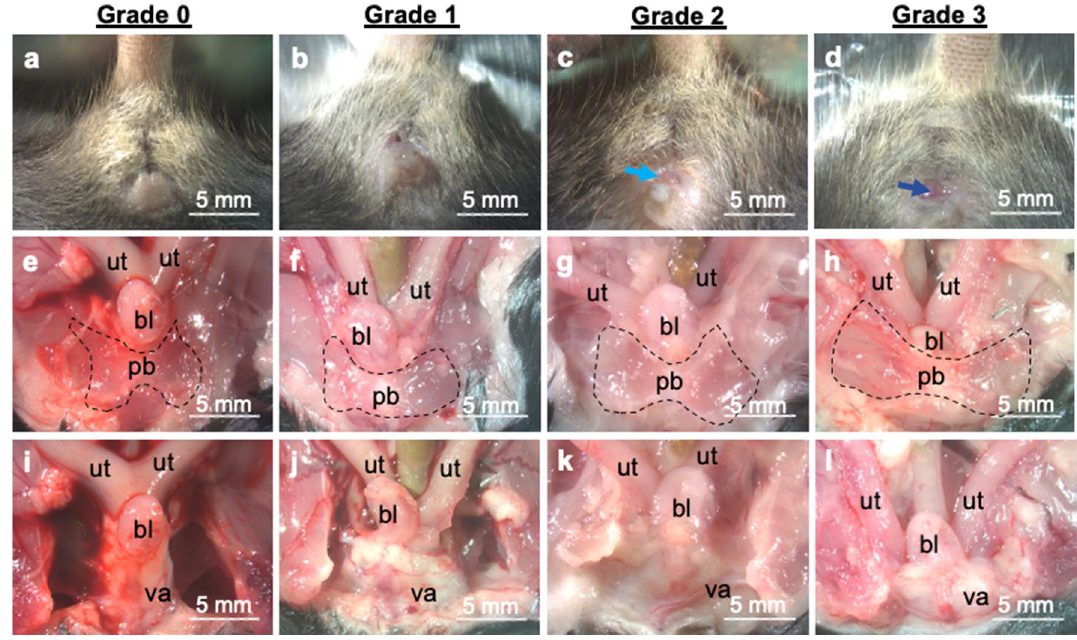
Figure 1. Evaluation of mouse pelvic organ prolapse. Representative images of grade 0 prolapse in the wildtype control ( a ), and grade 1 ( b ), 2 ( c ), and 3 ( d ) prolapse in the fibulin-5 deficient mice. The Fbln5 +/+ and Fbln5 +/− mice did not display bulging or herniation of the pelvic organs ( a ). The bladder (bl) and bifurcation of the uterine (ut) horn were superior to the pubic bone (pb; dashed line) as shown ( e , i ). Mice with grade 1 prolapse displayed a small but detectable perineal bulge ( b ). Mice with grade 2 prolapse displayed bulging and herniation (light blue arrow) of the pelvic organs ( c ). In mice with grade 1 and 2 prolapse the bladder was superior to the pubic bone ( f , g , j , k ). In mice with grade 1 and 2 prolapse bifurcation of the uterine horn was inferior to the pubic bone descended towards the vagina (va). In grade 3 prolapse ( d ) the cervix was visualized at the vaginal opening (dark blue arrow) with downward descent of the bladder ( h , l